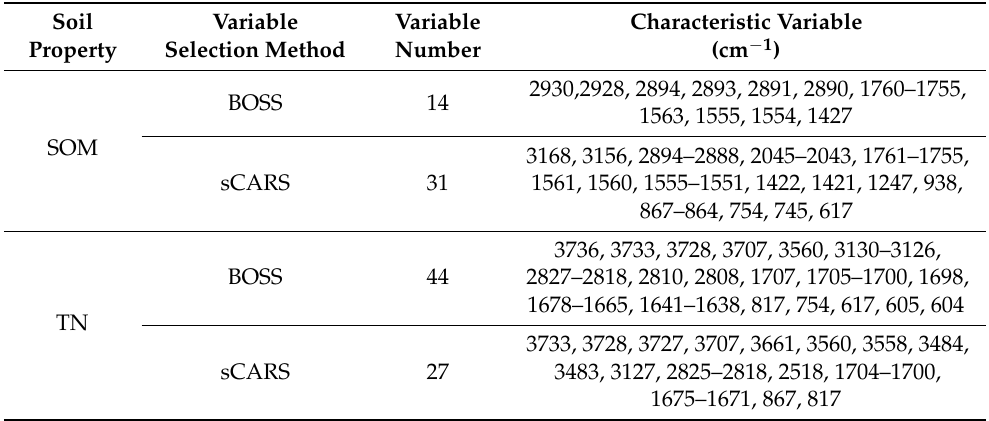
Table 3. Key wavenumbers (MIR) identified from the BOSS and sCARS